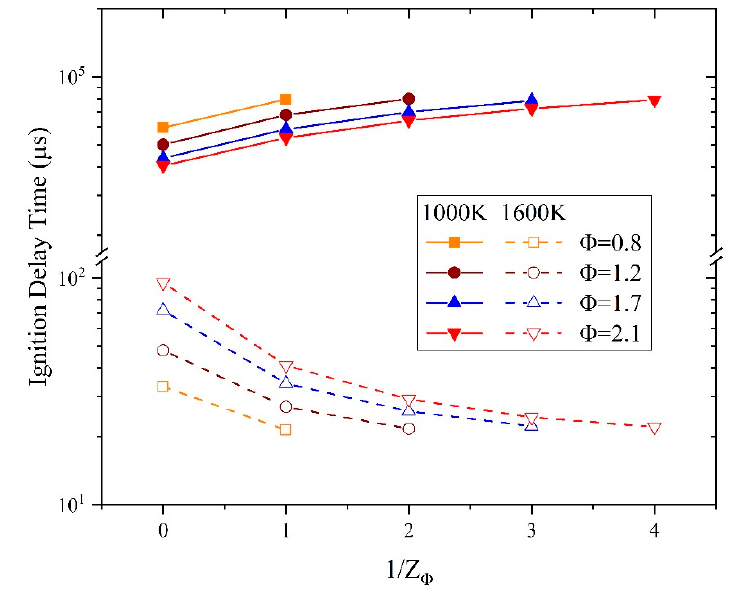
Figure 7. Comparison of the ignition delay times of air–light hydrocarbon mixing gas at the reciprocal of each mixing degree at temperatures of 1000 and 1600 K, respectively.